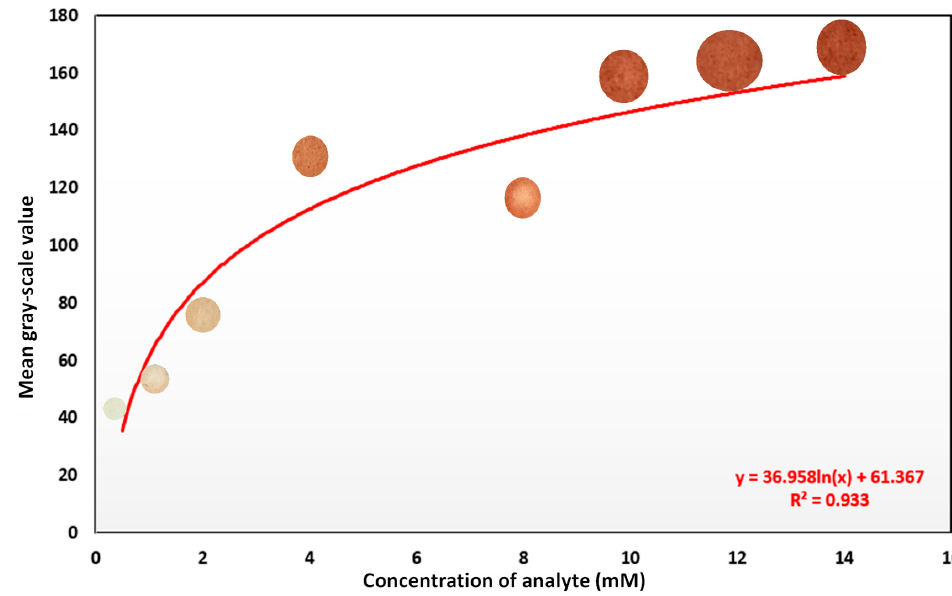
Figure 12. Response curve of the spot-based glucose assay. The response curve is represented with the solid line and was obtained from a non-linear curve fit of y = 36.958 ∗ ln ( x ) + 61.367 with an R 2 = 0.933.